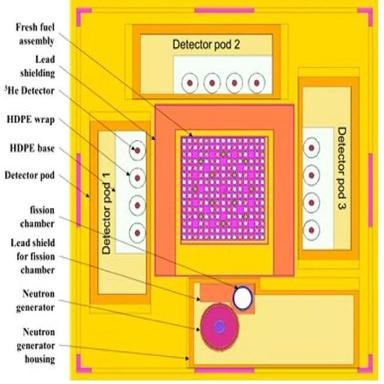
Cross Section of DDA instrument with fuel assembly.